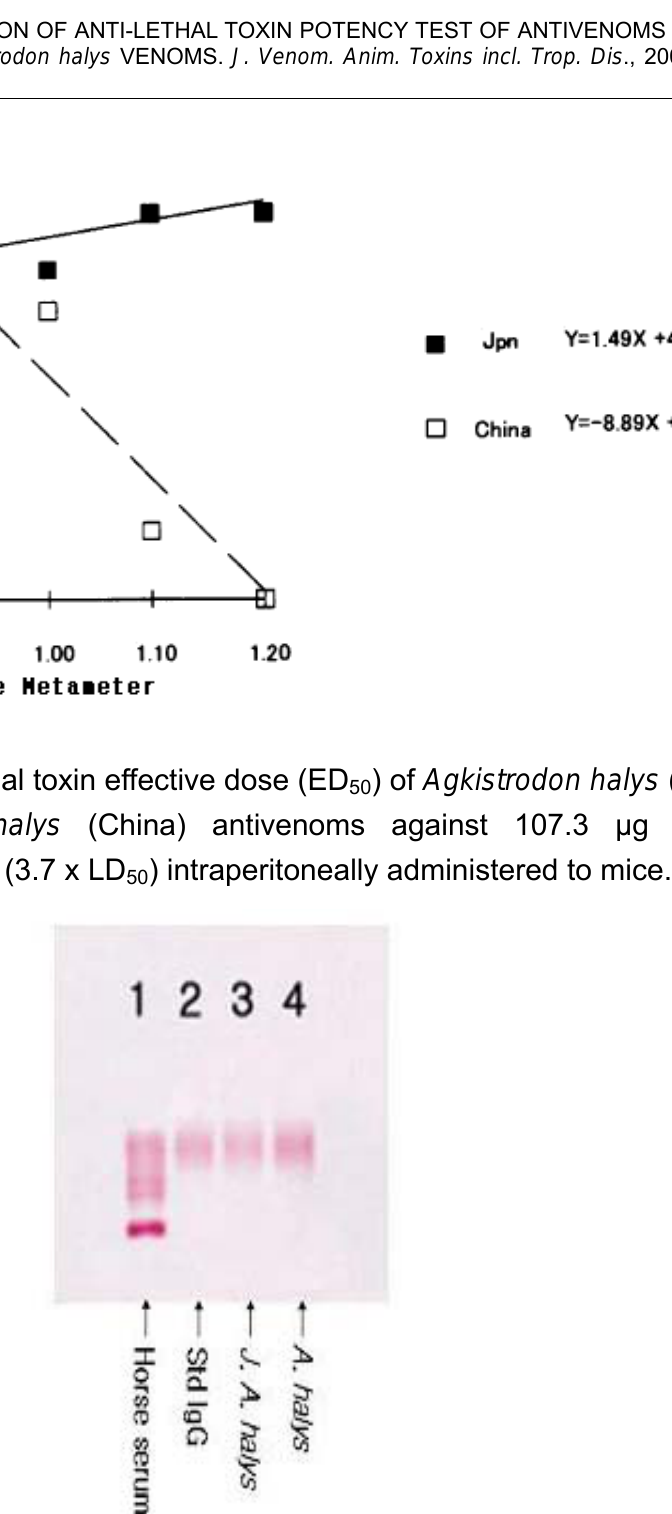
Figure 5: Analysis of electrophoresis. Lane 1: horse serum; Lane 2: standard immunoglobulin; Lane 3: Jiangzhe Agkistrodon halys antivenom against Jiangzhe Agkistrodon halys venom; Lane 4: Agkistrodon halys antivenom against Agkistrodon halys